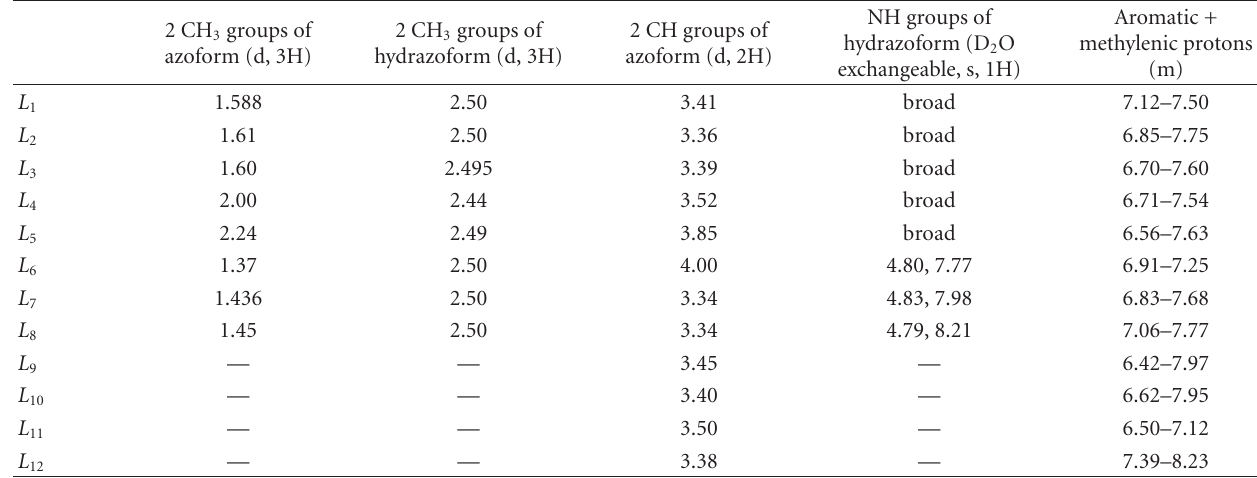
Table 3: 1 HNMR spectroscopic data of the ligands ( δ /ppm).